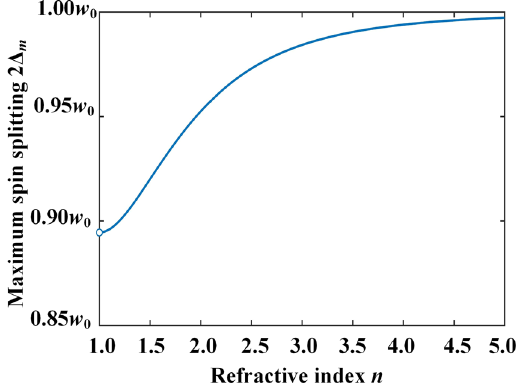
Figure 3. The dependence of the maximum IPSS 2 Δ m on the refractive index of the prism n